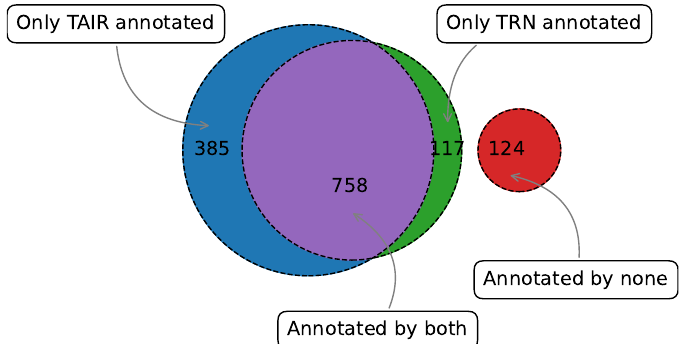
Figure 6. TF function assignment capacity of the TRN compared to the reference database of